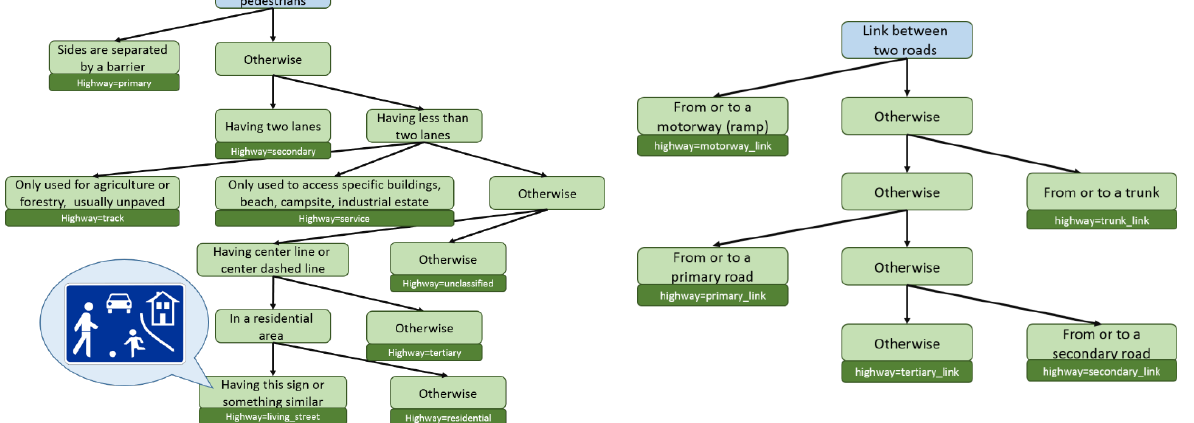
Figure 2. Expanded view of "Cars and pedestrians" box in Figure 1.